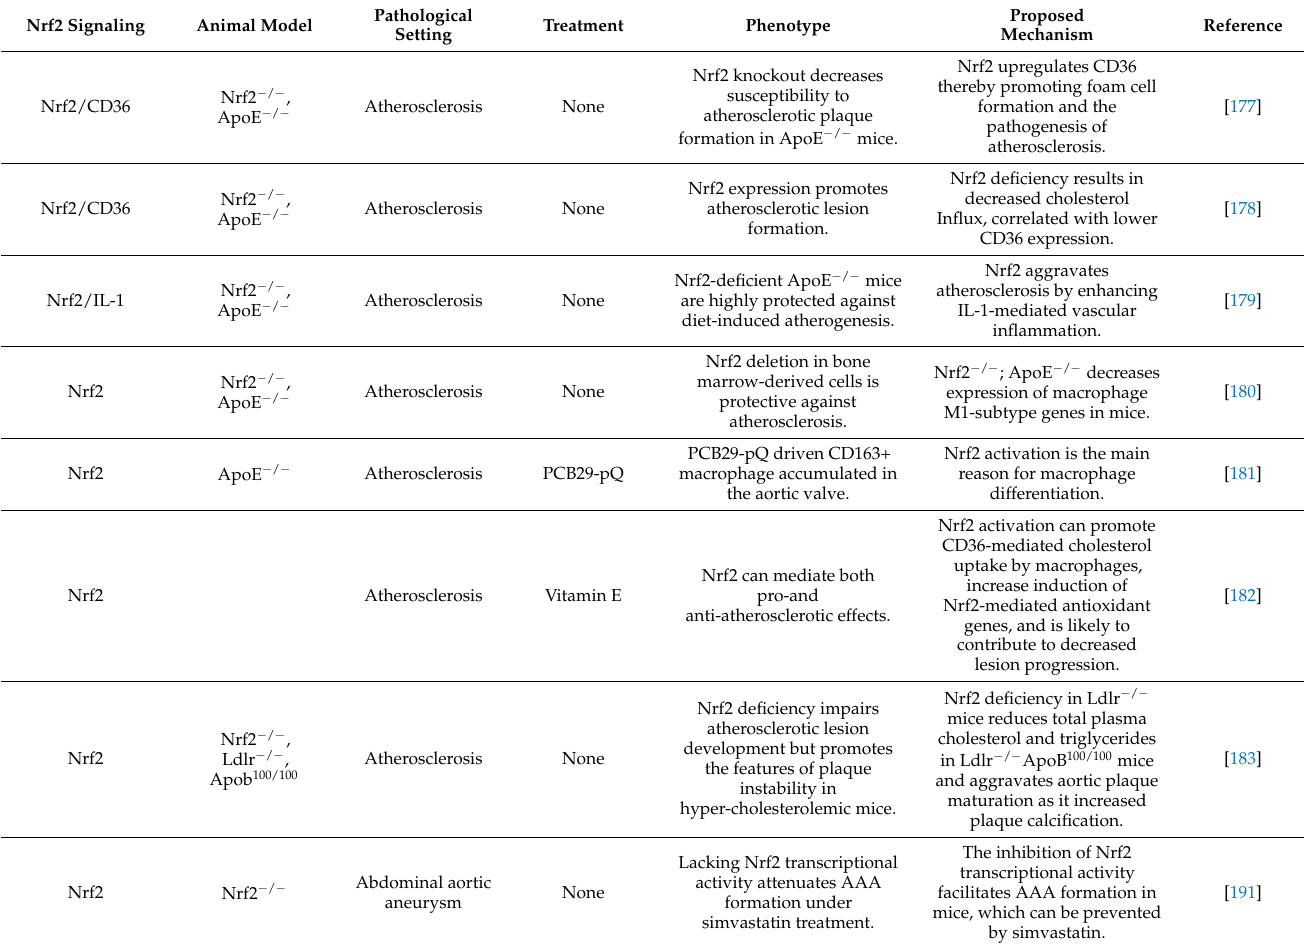
Table 3. Nrf2 signaling cascades in vascular damage and